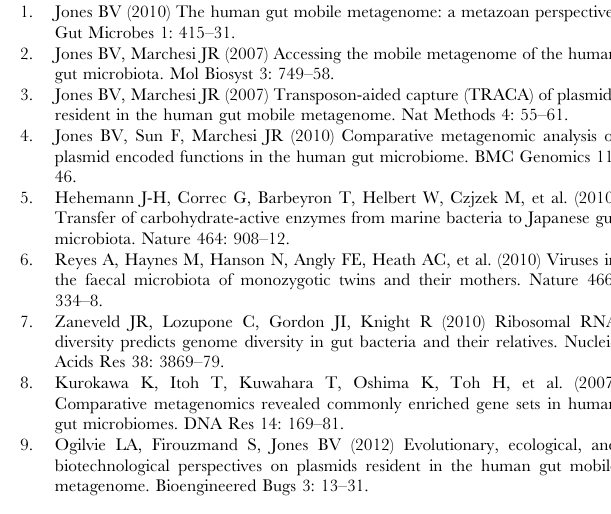
Table S2. w B124-14 predicted ORFs and putative func- tional assignments. 1 ORF numbers and functional assign- ments correspond to those represent on genetic maps of the F B124-14 genome presented in Figure 2. 2 ORFs were assigned roles relating to broad functions based on results of BlastP and conserved domain searches of translated ORF amino acid sequences. Table S3 Bacterial chromosomes, phage genomes and metagenomic fragments used in phage phylogenetic analyses and ecological profiling ( Figures 7 and 8 ). 1 – Classification, refers to classification of genomes used for ecological profiling in Figure 8B. Genomes from phage infecting host bacteria belonging from a particular genus were assigned one of three broad categories based on the relationship of bacterial host genus with the human gut microbiota. For the purposes of this analysis only bacteriophage with 4 or more representatives infecting a particular genus of bacteria were included (540 complete phage genomes, representing 31 bacterial genera).